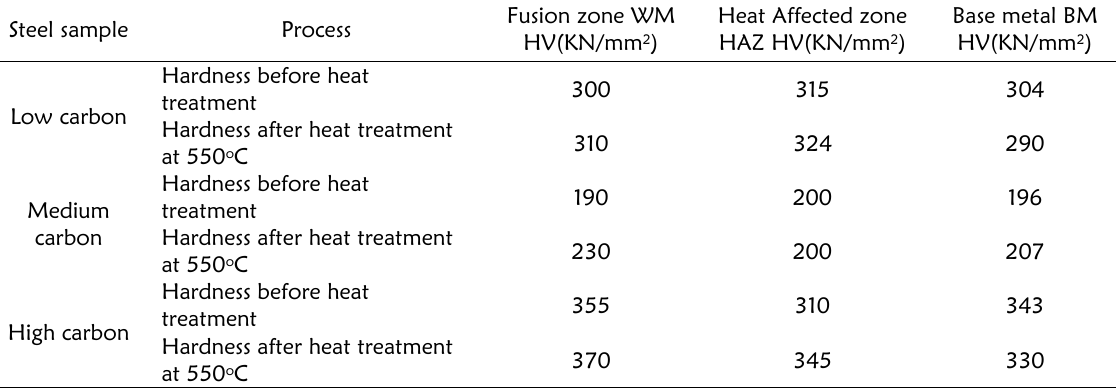
Table 5: Hardness value of the samples at different zone